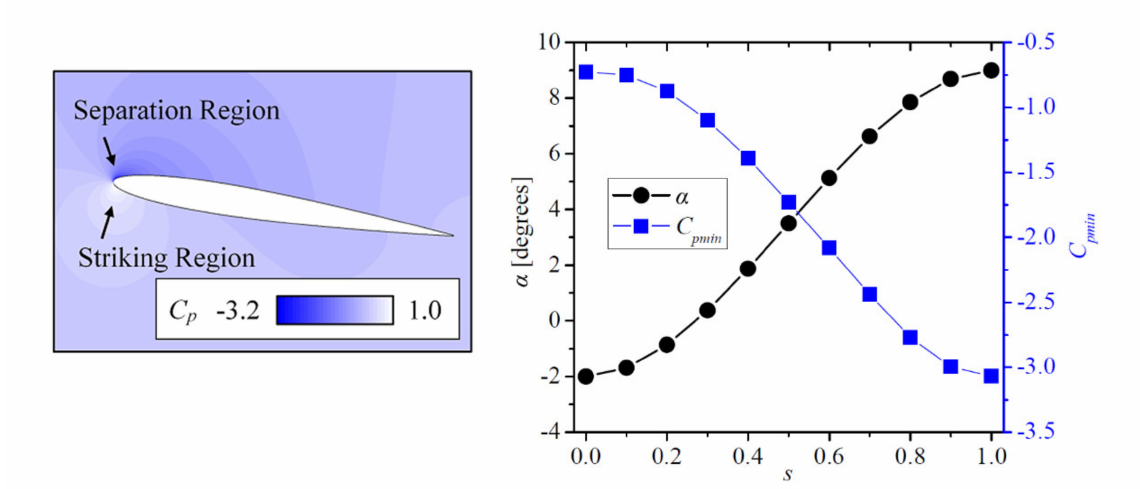
Figure 8. Minimum pressure coefficient C pmin and installation angle α at different spanwise s positions with local contour of C p on the mid-span plane.